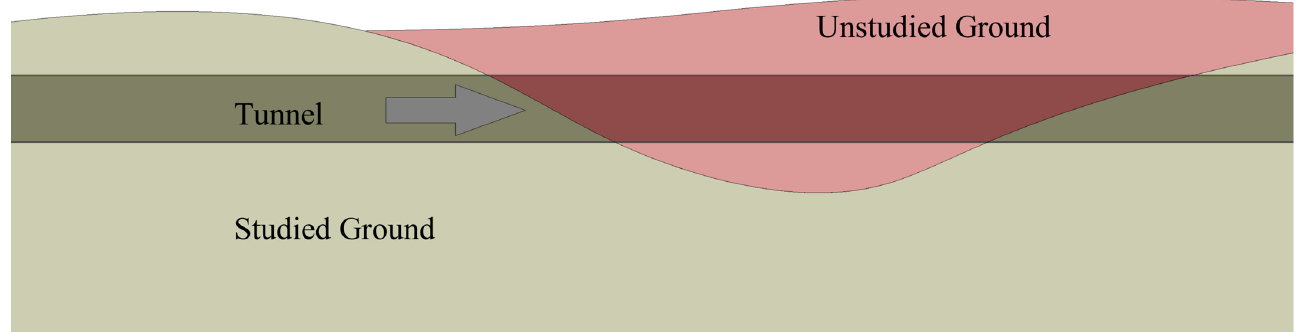
Figure 1. Illustration of sudden change in ground conditions.